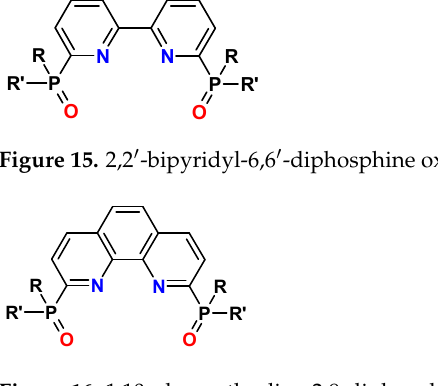
Figure 16. 1,10-phenanthroline-2,9-diphosphine oxides ( PhenDPO